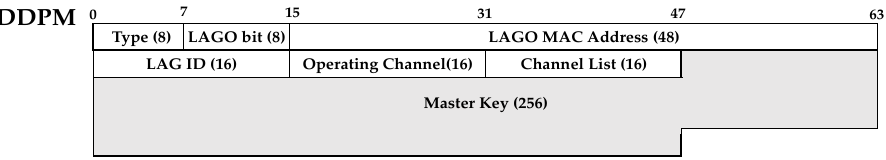
Figure 6. An internal message of a vehicle node.